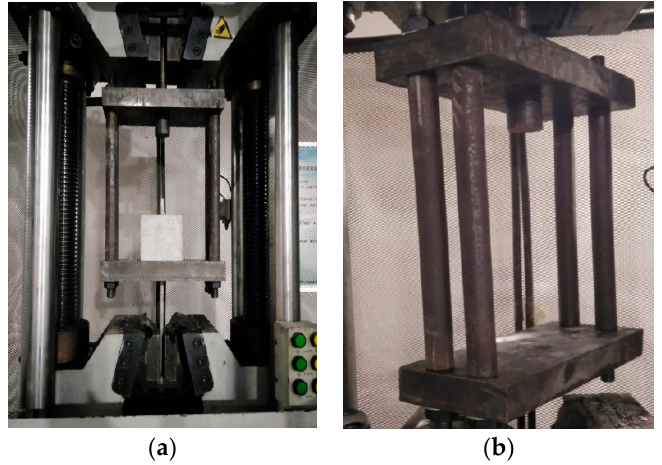
Figure 4. The center pull-out test device includes ( a ) 1000 kN Xinsansi electro-hydraulic servo testing machine, ( b ) reaction force frame structure diagram.